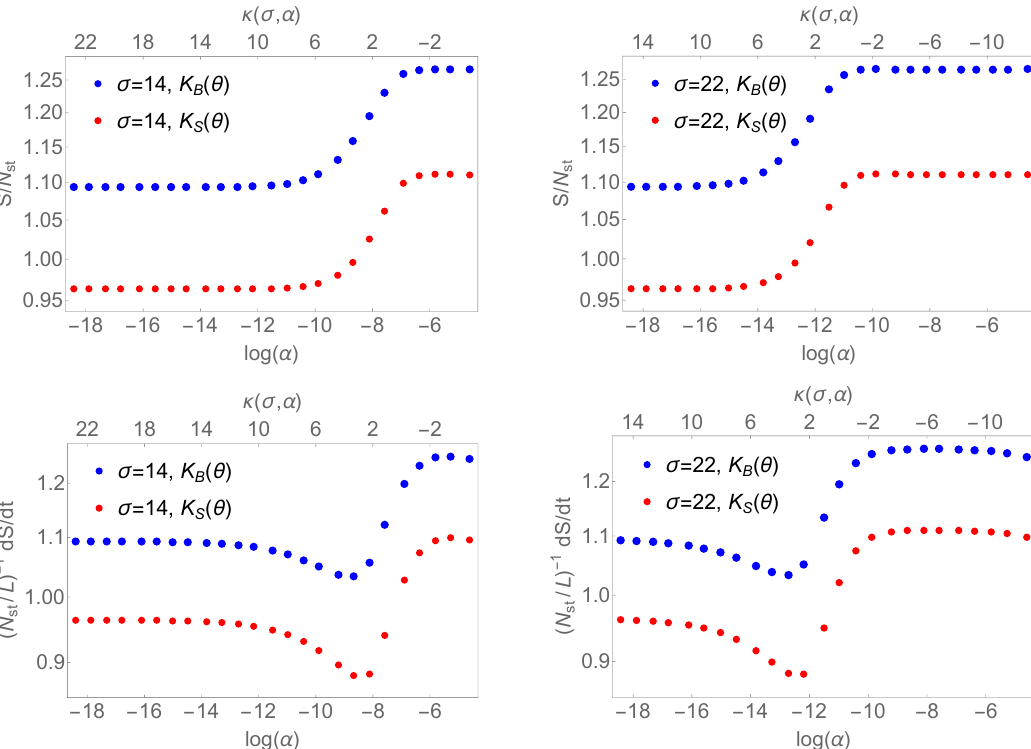
Figure 3 . S { N st , L { N st and d S { d t against α after quenches with different K -functions and fixed resonance parameter σ (reported in the